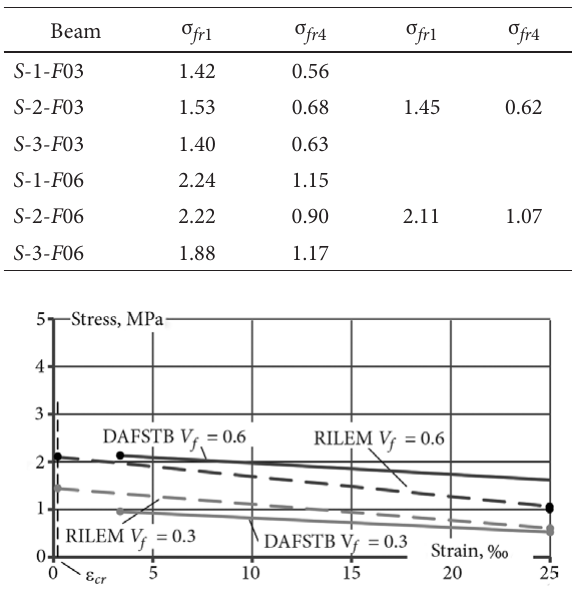
Fig. 6. Residual stress diagrams obtained by the Rilem and the DAfStb methodologies